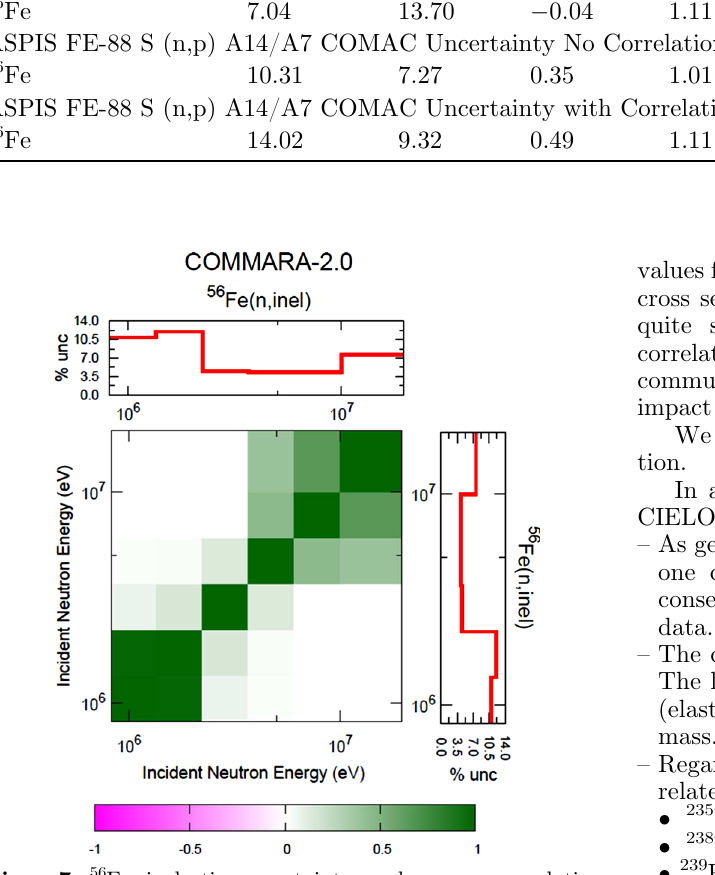
Fig. 7. 56 Fe inelastic uncertainty and energy correlation: